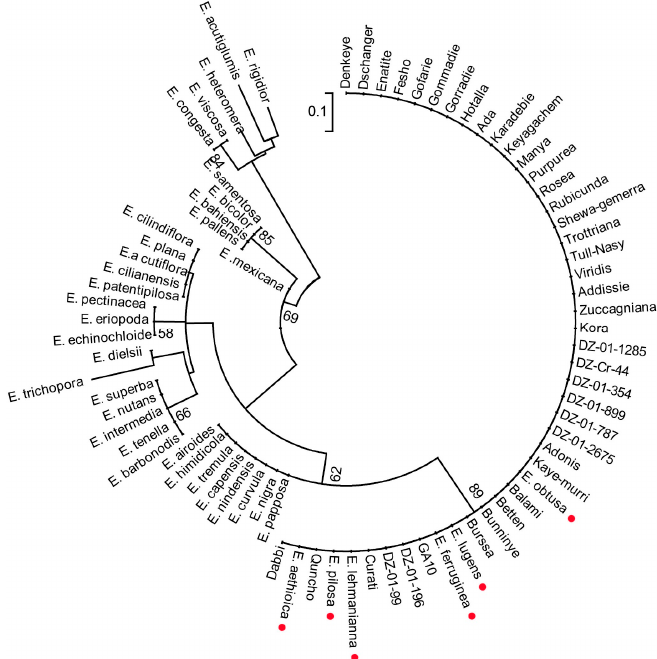
Figure 4. Maximum likelihood phylogenetic tree for species of the genus Eragrostis . The evolutionary history was inferred by using the maximum likelihood method based on the Tamura-Nei model in molecular evolutionary genetics analysis using maximum likelihood, evolutionary distance, and maximum parsimony methods (MEGA). The tree with the highest log likelihood is shown. Bootstrap values are shown above the branches. The tree is drawn to scale, with branch lengths measured in the number of substitutions per site. The analysis involved 79 nucleotide sequences. Codon positions included were 1st+2nd+3rd+Noncoding. All positions containing gaps and missing data were eliminated. The six wild Eragrostis species within the tef clade are noted by a red point. 3.7. Wild Species Show High Level of Genetic Differentiation Compared to the Tef Cultivars Subpopulation